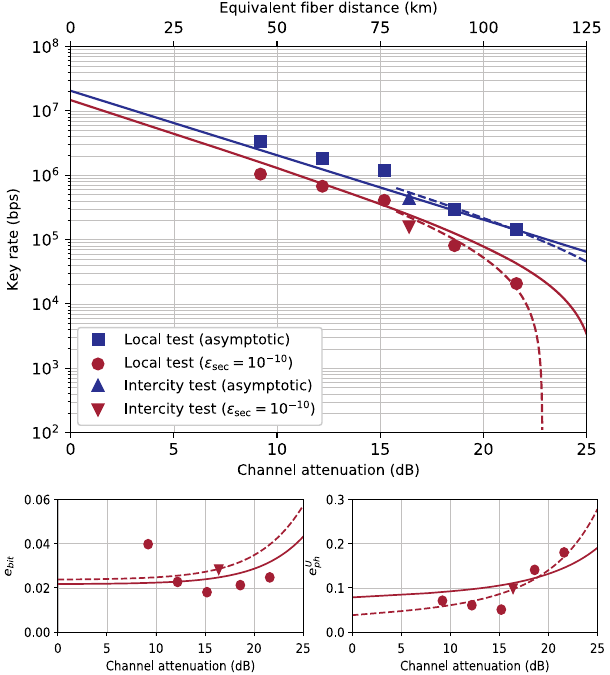
FIG. 3. Top: Experimental SKRs at different channel losses. The (blue) squares and upright triangles are asymptotic SKRs for the local test and the 43-km metropolitan intercity test, respec- tively. Similarly, the (red) circles and inverted triangles are the SKRs calculated within the composable security framework with ε 10 − 10 for the local test and the metropolitan field test, sec ¼ respectively. In the local tests, a variable attenuator is used to provide higher attenuation beyond the channel ’ s 0.2-dB loss. Solid and dashed lines correspond to numerical simulations of the SKRs for the local test and the intercity test, respectively. Bottom: Bit error rate ( e ) and upper bound to the phase error rate ( e U bit against channel attenuation. The symbols used here are the same as the ones